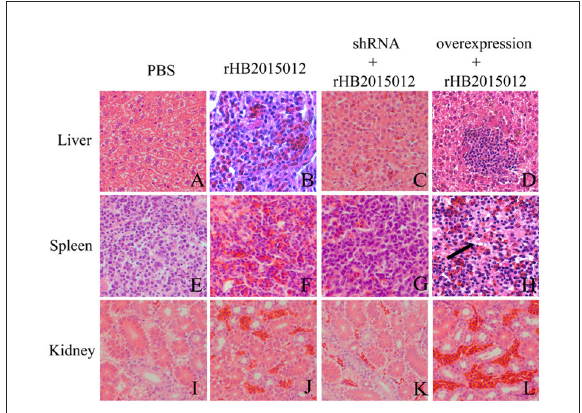
FIGURE10 Pathological observations (H,E) of ALV-A infection at 100 days (400 × ). (A,E,I) Liver, spleen and kidney tissue sections in PBS group. ALV-A rHB2015012 infection caused liver congestion (B) , and tissue congestion was relieved after A20 expression was interfered with (C) , while A20 overexpression aggravated congestion with lymphocyte infiltration (D) . ALV-A rHB2015012 infection caused spleen congestion (F) , and tissue congestion was relieved after A20 expression was interfered with (G) , while A20 overexpression aggravated congestion with myeloma-like cells (H) . ALV-A rHB2015012 infection caused kidney congestion (J) , and tissue congestion was relieved after A20 expression was interfered with (K) , while A20 overexpression aggravated congestion (L)